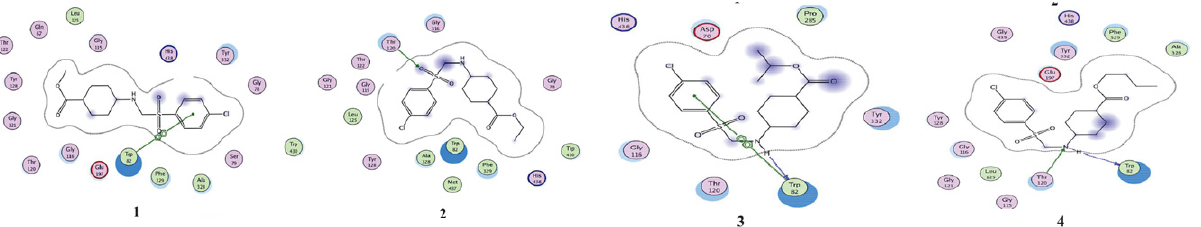
Figure 7. Interactions of synthesized esters with BChE